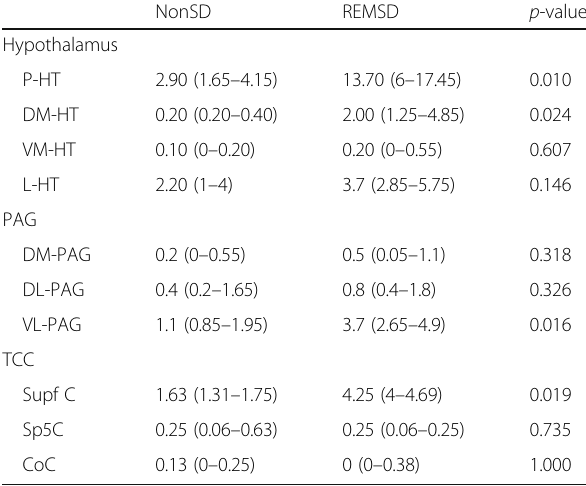
Table 1 The median number of Fos-positive cells (25th – 75th percentile) per hemisection per animal in both